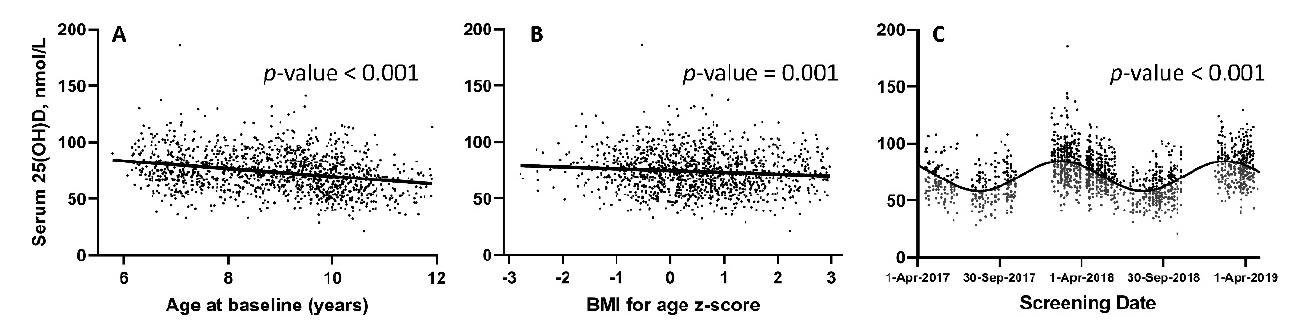
Figure 2. Serum concentrations of 25(OH)D by age ( A ), BMI ( B ) and date of sampling ( C ). Regression lines are fitted to ( A ) [slope: − 3.42 (95% CI: − 4.07 to − 2.76)] and ( B ) [slope: − 1.54 (95% CI: − 2.43 to − 0.65)]; best fit line (sinusoidal curve) fitted to ( C ).